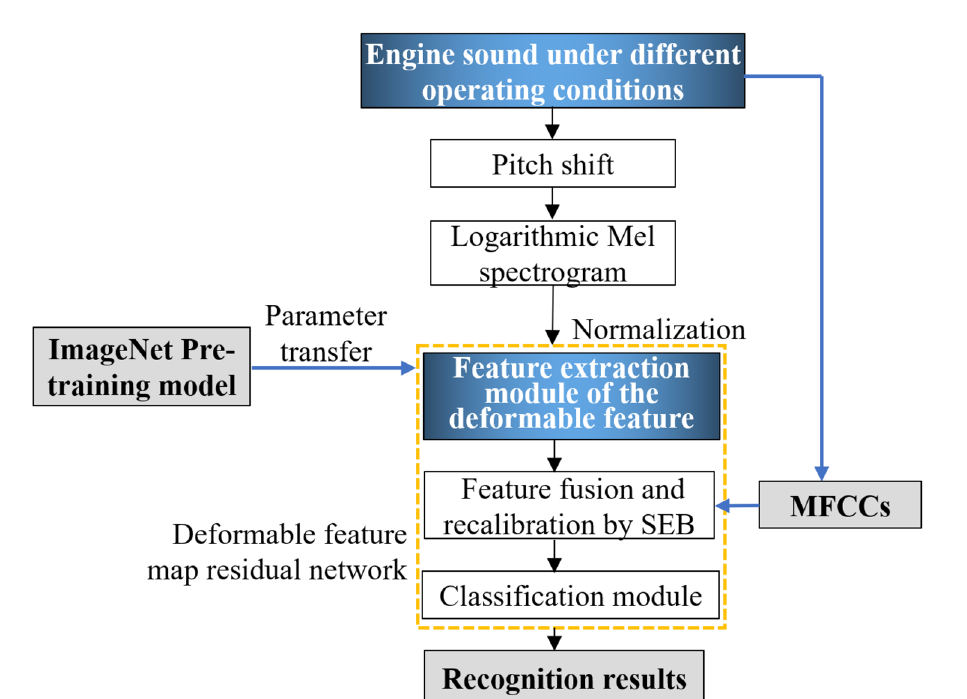
Figure 10. Flowchart of engine sound recognition using deformable feature map residual